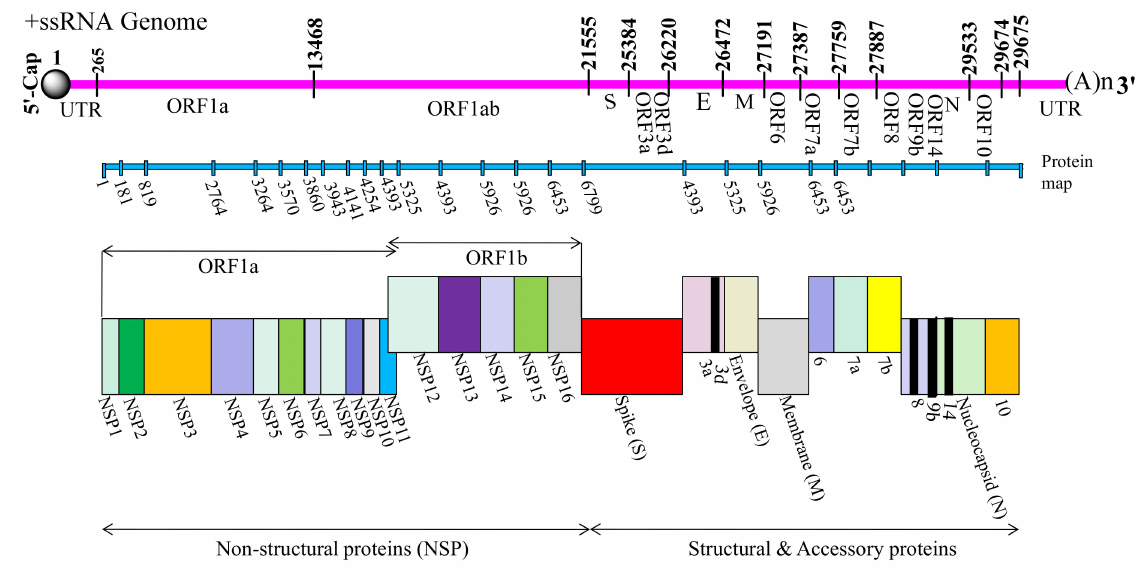
Figure 1. Genomic arrangement of SARS-CoV-2. The genomic organization of the SARS-CoV-2 shows sequential ar- rangement of various non-structural, structural and accessory genes as follow: 5 (cid:48) -cap-leader-UTR-replicase-S (Spike)–E (Envelope)-M (Membrane)-N (Nucleocapsid)-3 (cid:48) UTR-poly (A) tail with accessory genes such as 3a, 3d, 6, 7a,7b, 8, 9b, 14, and 10 interspersed among the structural genes preceding 3 (cid:48) end of the viral RNA